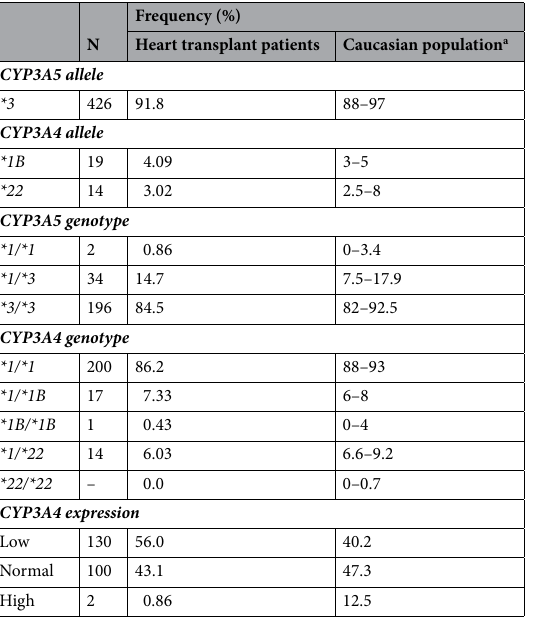
Table 2. Frequencies of CYP3A alleles, genotypes and CYP3A4 expression in heart transplant patients and in Caucasian population. a Allele frequencies in Caucasian population according to 38 ; Genotype frequencies in Caucasian population according to 22,41,72,73 , CYP3A4 expression frequencies according to 35 .